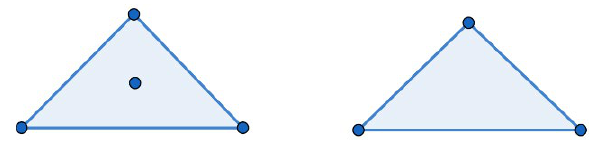
Figure 1. Mini-element P 1 − Bubble / P 1 in 2 D .